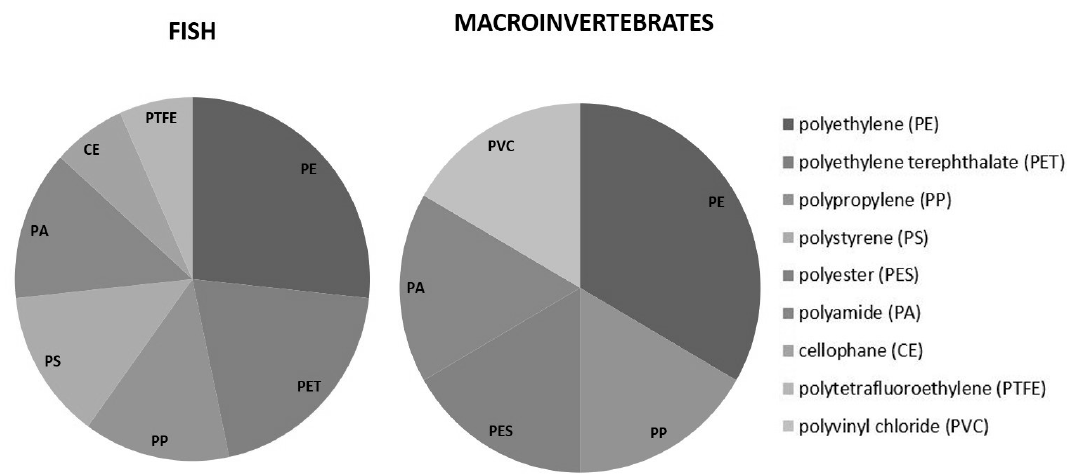
Figure 9. Types of microplastic polymers in freshwater biota (data were available only for fish and macroinvertebrates).